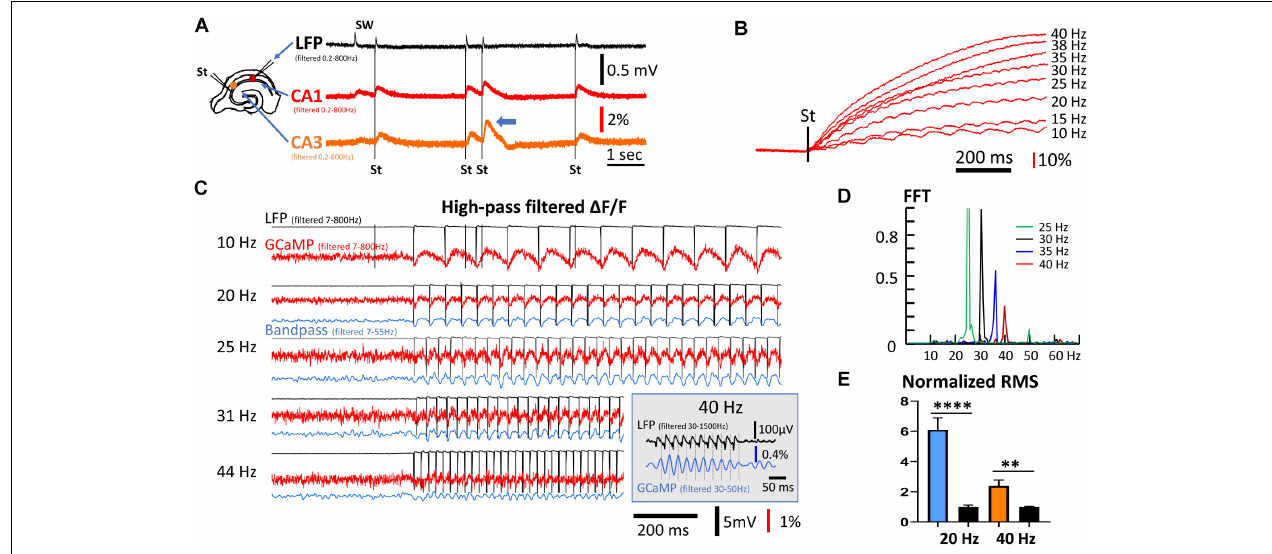
FIGURE 3 | Frequency response of population GCaMP signals. (A) GCaMP signals in response to mild electric stimuli. Left: The arrangement for the stimulation and recording. Stimuli were applied to CA3 and response was recorded in both CA1 and CA3. The stimulation intensity was adjusted so that the evoked response had an amplitude similar to the SW amplitude in the LFP signals. Note that double stimuli induced larger responses to the second shock, even with long inter-stimulus intervals of 500 ms (blue arrow head). (B) High frequency stimuli caused a ramp accumulation of GCaMP signals. Note that the ramp signal was much larger and slower than the response to individual stimuli. (C) Evoked GCaMP signal to high frequency stimuli. A high frequency component can be seen in wide-band filtered signals (red traces, 7–800 Hz). Narrow band filtered (blue traces, 7–55 Hz) improved signal-to-noise ratio. (Inset) In a follow-up experiment, 10 mild stimuli (1.4 × threshold) at 40 Hz was given to CA3. A narrow bandpass filter (30–50 Hz) of the CA1 GCaMP signals reveals a clear one-to-one correlation between individual stimulus pulses (filtered 30–1500 Hz) and the GCaMP response. (D) Power spectrum of the GCaMP signals, normalized to the power at 30 Hz. The signal power reduced to ∼ 50% at 35 Hz and ∼ 25% at 40 Hz. Green peak at the 50 Hz is the 2nd harmonic of the 25 Hz peak. High frequency, weak stimuli experiments were done on three slices from three animals. Data in panels (A,D) are from different slices receiving stimuli of slightly different frequency. (E) RMS power quickly reduced in high frequency. The RMS power during 20 or 40 Hz stimulations was normalized to the RMS noise in the same trial when there was no stimulation. Blue and left black bars, narrow band-pass filtered between 5–30 Hz, n = 8 trials, three slices from three animals, ∗∗∗∗ p < 0.0001 (unpaired t -test). Orange and right black bars, narrow band-pass filtered between 25–50 Hz, n = 9 trials, three slices from three animals, ∗∗ p = 0.0022 (unpaired t -test). Error bars indicate